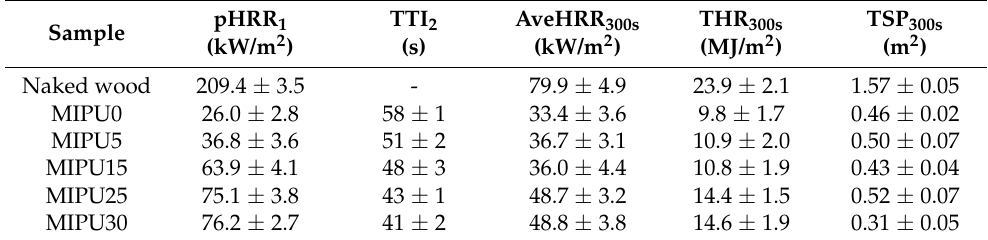
Figure 10. ( a , c ) are the heat release rate (HRR) curves of samples with the coating and the naked wood sample; ( b , d ) are the total heat release (THR) curves of samples with the coating and the naked wood sample. Table 2. CONE data of the